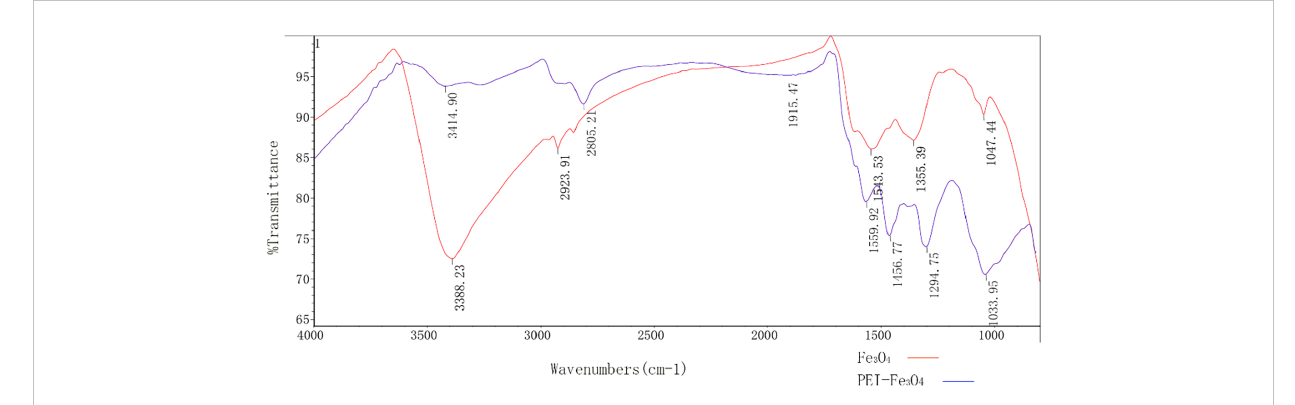
FIGURE 6 FTIR spectra of Fe 3 O 4 nanoparticles and PEI -Fe 3 O 4 nanoparticles.